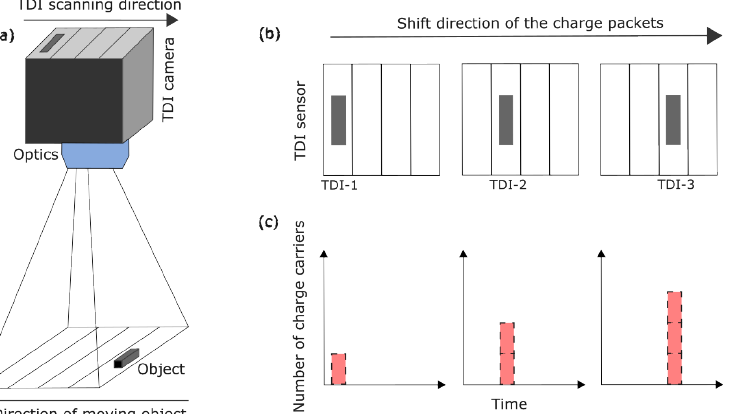
Figure 1. Working principle of the time-delay integration process. ( a ) TDI camera detects a moving object. ( b ) Position of the moving charge packet in a pixel line that is synchronous with the object’s movement. ( c ) Charge accumulation over time as a result of the TDI